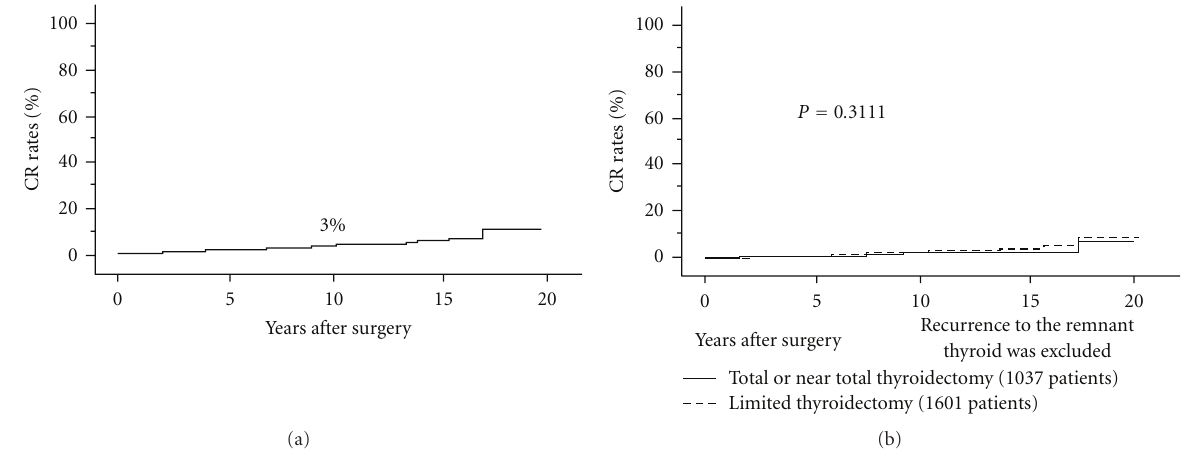
Figure 4: (a) CR rates of solitary T1N0M0 PTC patients. (b) CR rates of solitary T1N0M0 PTC patients who underwent total or near total thyroidectomy and those who underwent limited thyroidectomy excluding recurrence to the remnant thyroid. Recurrence to the remnant thyroid is ignored.